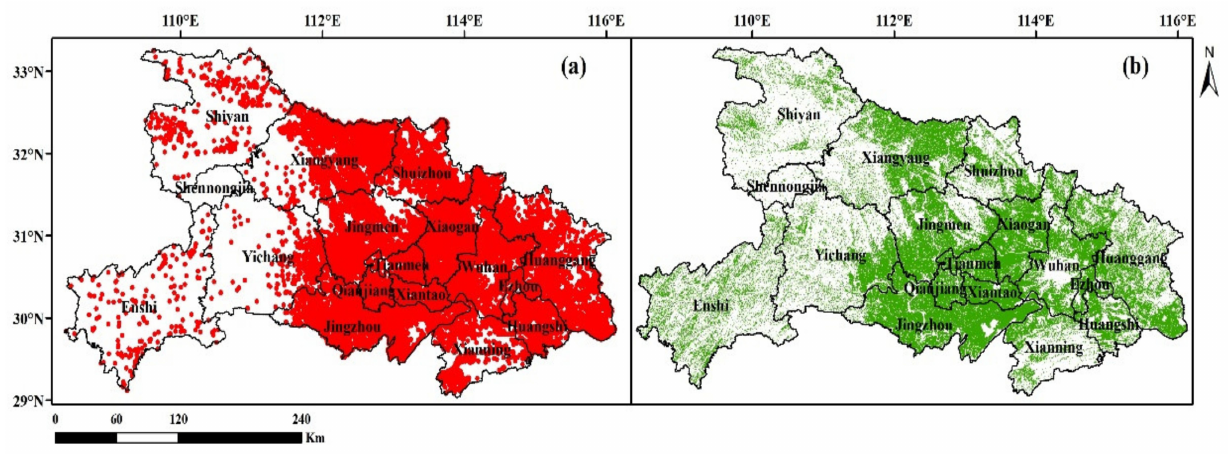
Figure 4. ( a ) The spatial distribution of crop fire points in Hubei from 2012 to 2020; ( b ) The spatial distribution of cultivated land in Hubei in